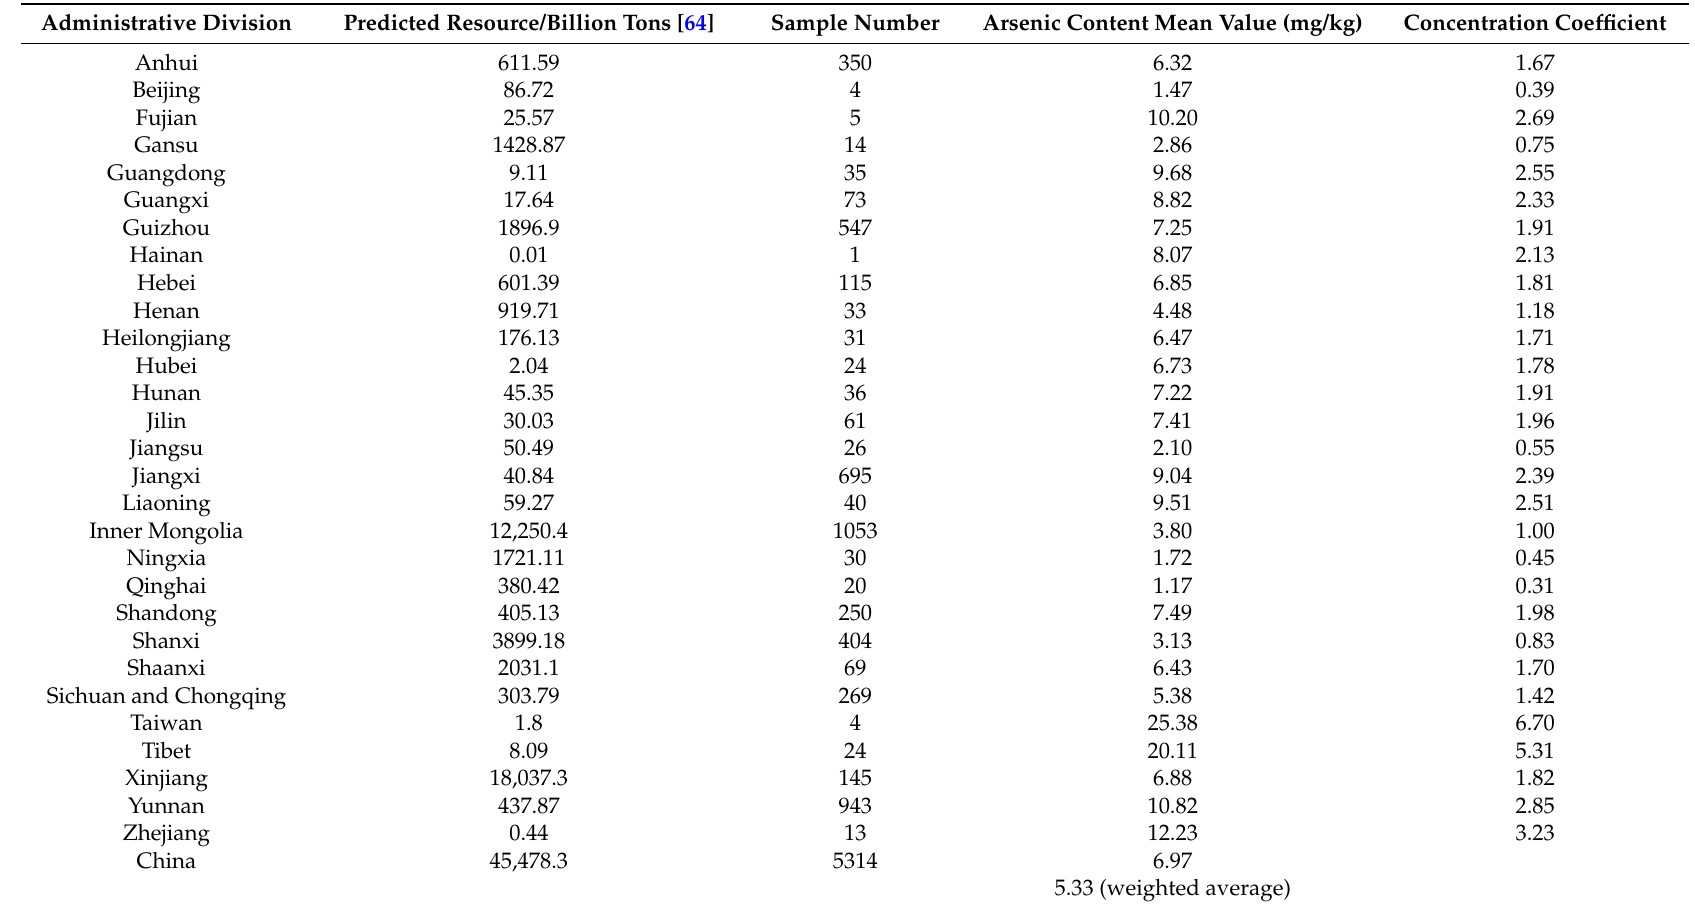
Table 2. Arsenic concentrations and predicted coal resources in individual provinces of